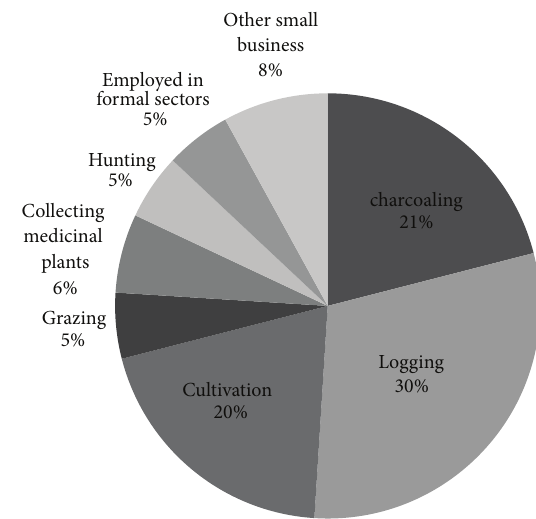
Figure 2: Major income sources of communities around Ngumbu- runi Forest